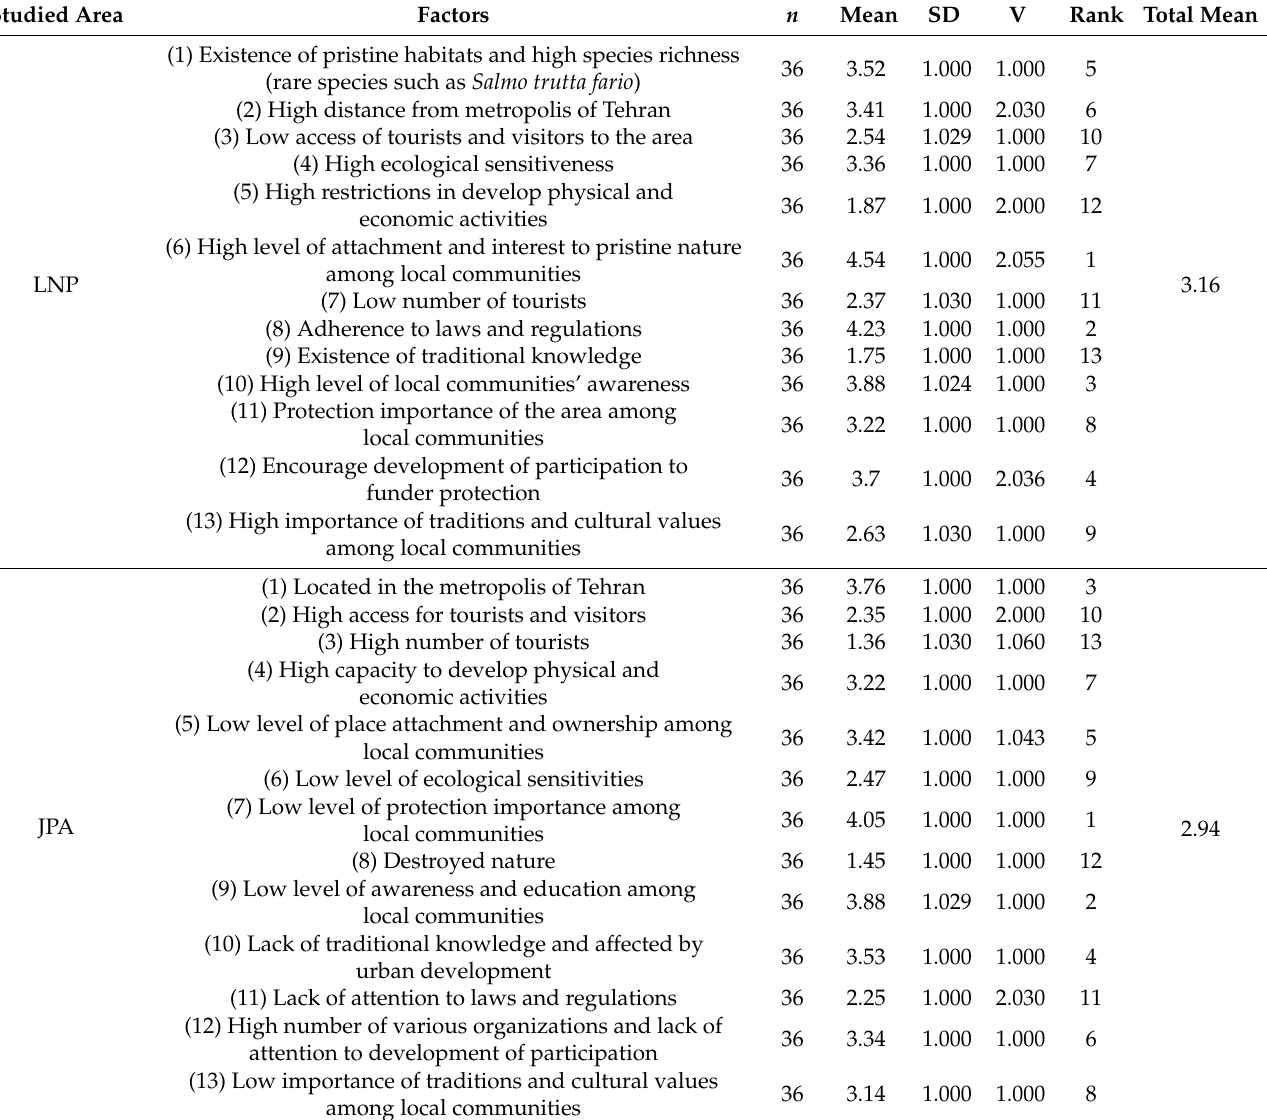
Table 7. List of factors influencing local community participation level in two protected areas in Iran